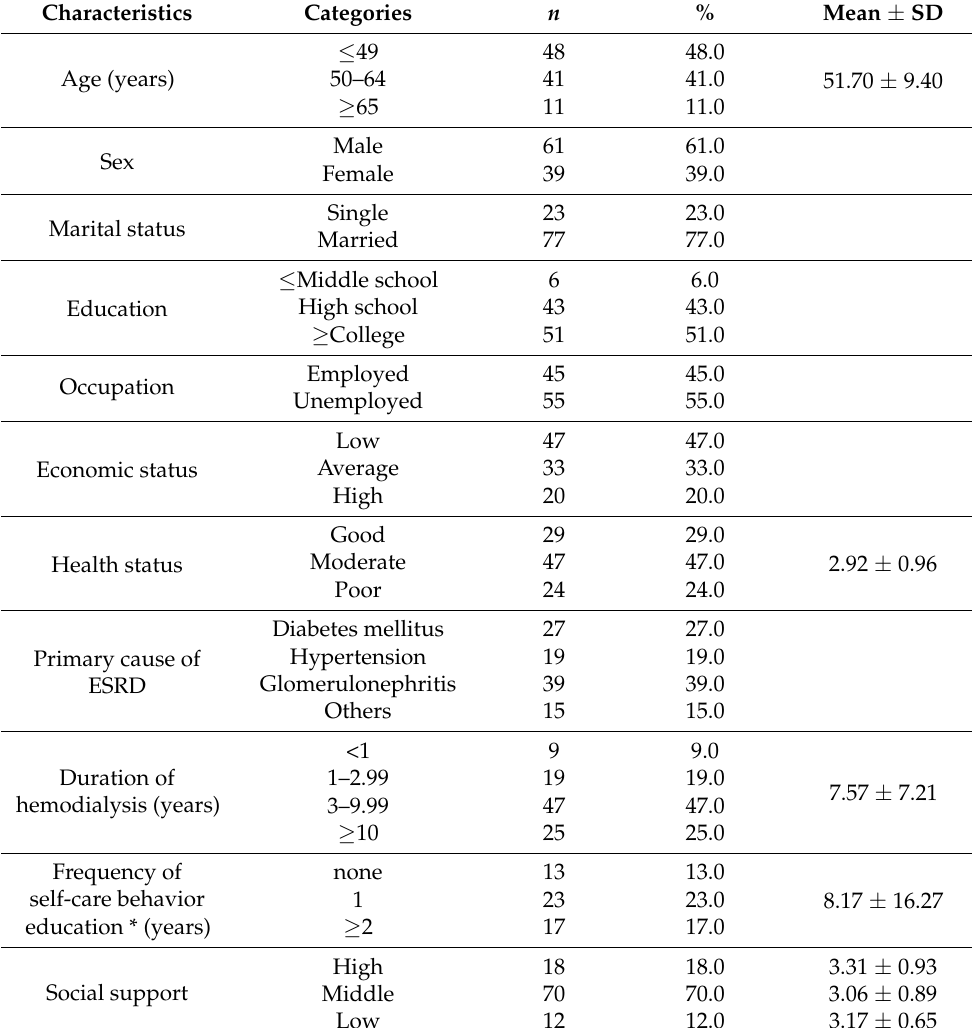
Table 1. Descriptive statistics of patient characteristics (n =